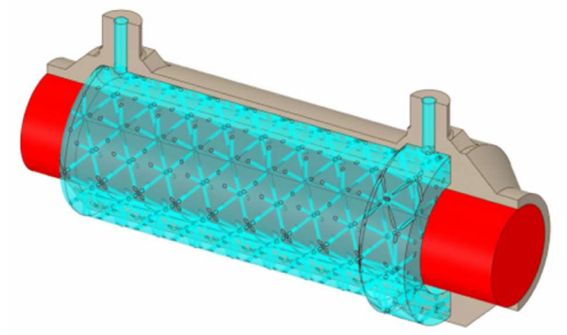
Figure 10. Structure design of the heat